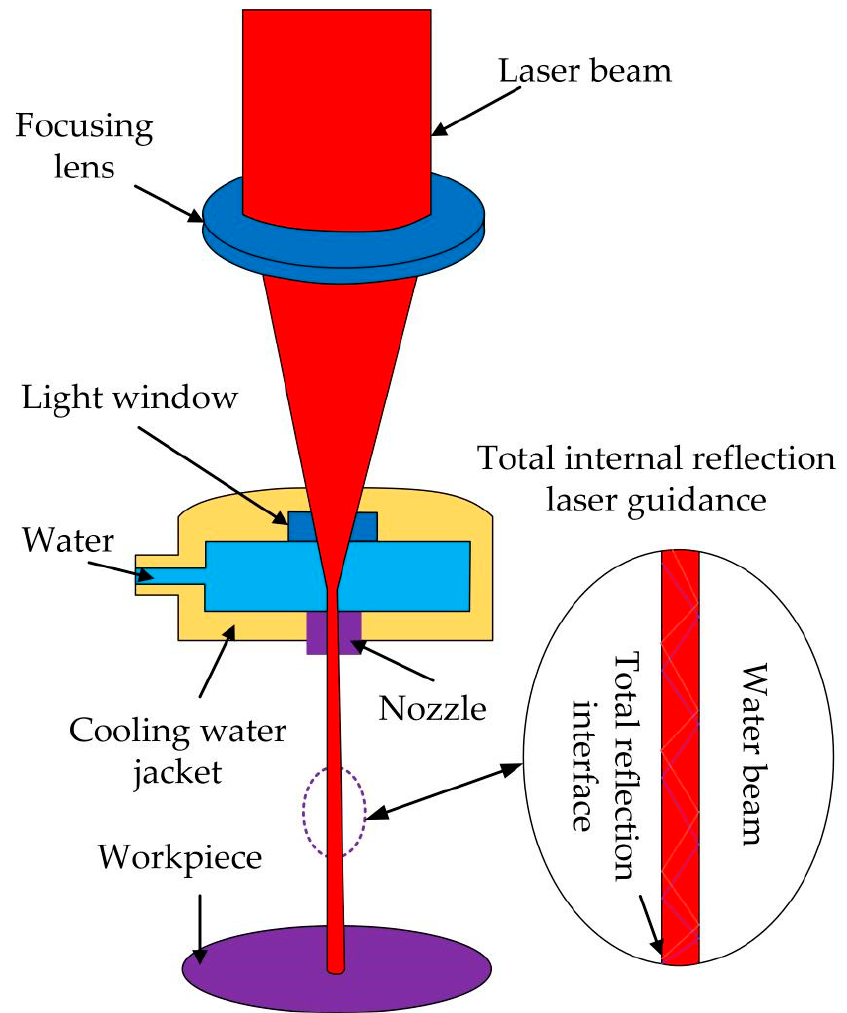
Figure 4. Principles of water-guided laser processing.